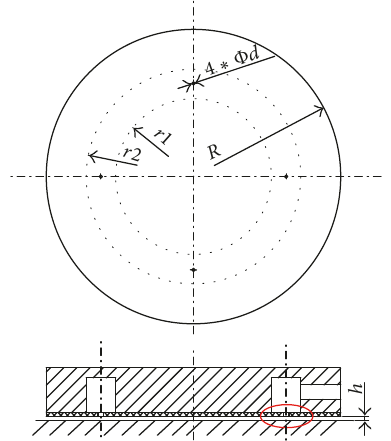
Figure 1: Schematic diagram of physical